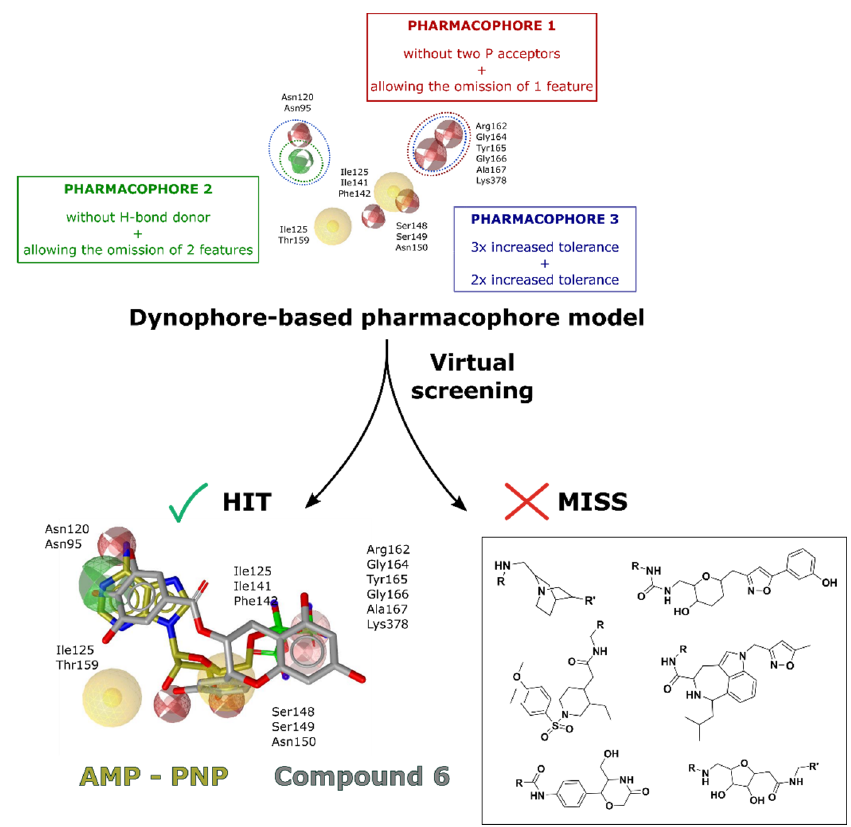
Figure 3. Dynophore refinement process in the creation of a new screening pharmacophore model. ( Top ) Designed Pharmacophore models 1–3 were used for virtual screening of compounds. Red spheres represent H-bond acceptors, green spheres represent H-bond donors, yellow spheres rep- resent hydrophobic interactions. ( Bottom left ) An active flavonoid (compound 6 ) aligned to Phar- macophore model 1 along with the experimental conformation of AMP-PNP for better comparison. ( Bottom right ) Structures of selected hit compounds that were found to be inactive in the experi- mental inhibition assay.